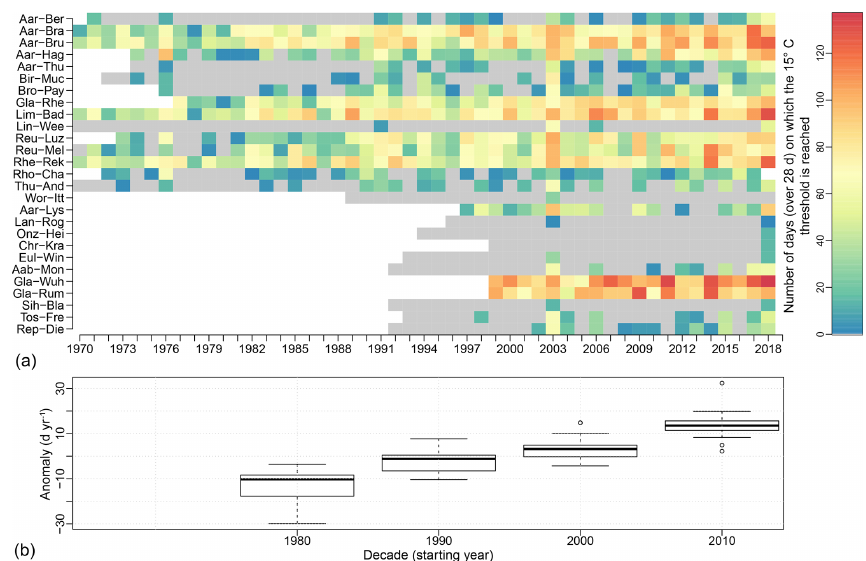
Figure 14. (a) Number of days per year when the water temperature was above 15 ◦ C for at least 28d (first 28d not counted). Abbreviations of catchment names are explained in Table 1. (b) Anomaly in the decadal mean number of annual days when the water temperature is above 15 ◦ C for at least 28d (first 28d not counted) for the 15 catchments where data are available since 1980. Anomaly with respect to the full period